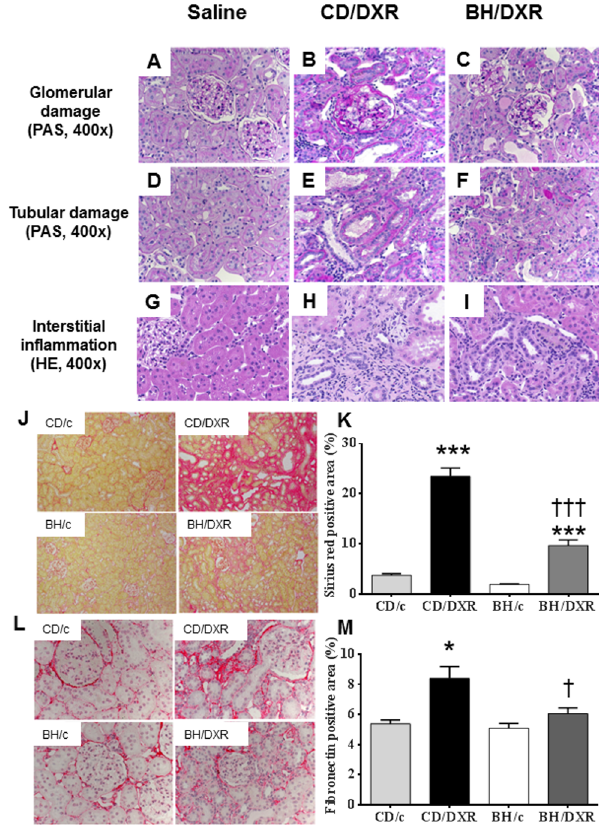
the affected areas. Middle row PAS staining) ( D-F ): Tubular damage in the affected areas. Lower